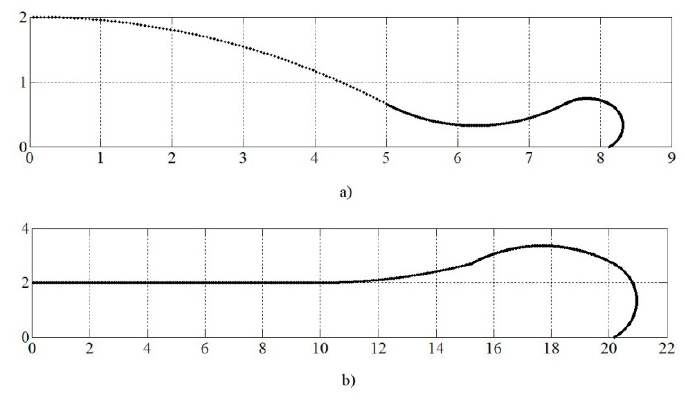
Figure 2. Splat section from an impact in μ m. ( a ) Slow impact ( b ) fast impact.